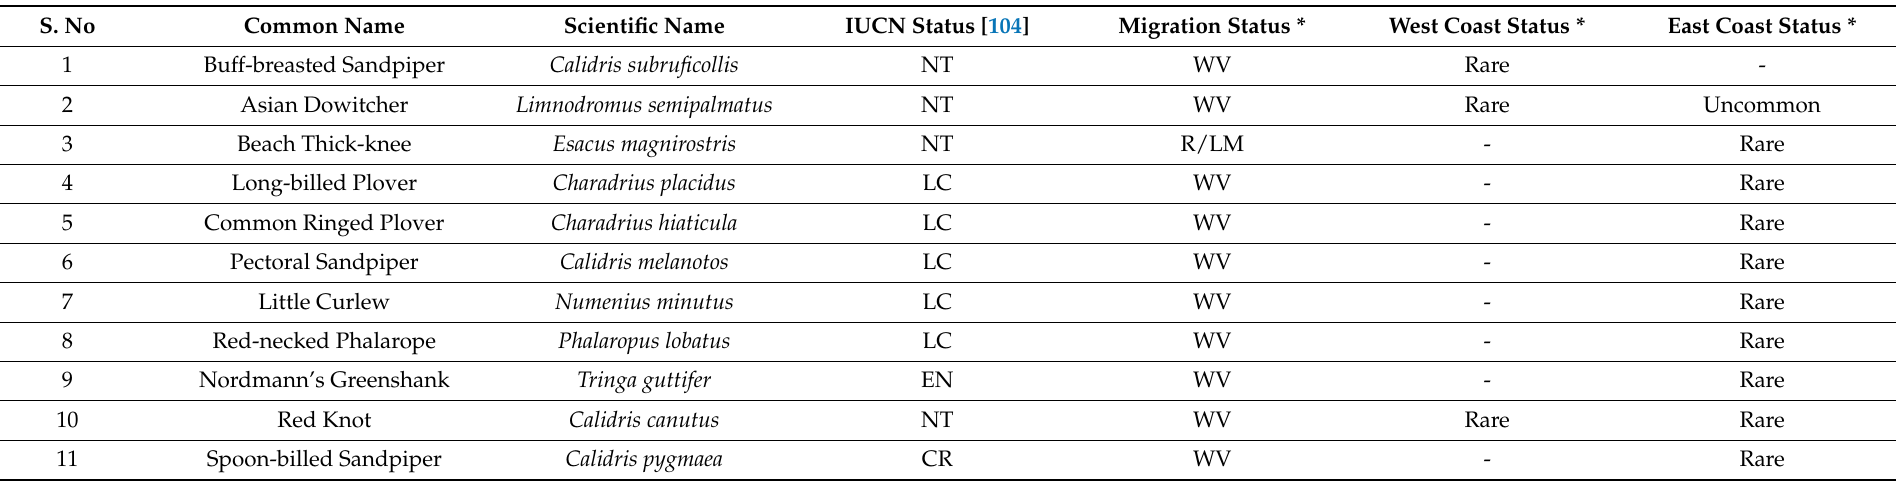
Table 2. Documentation of uncommon shorebird species from the west and east coast of